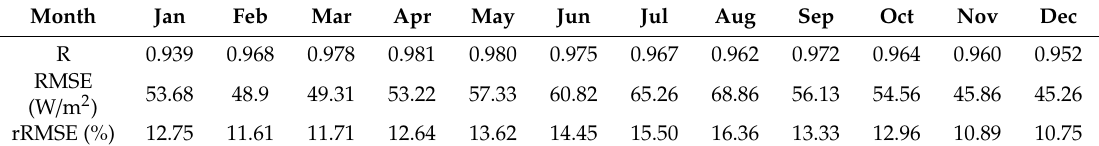
Figure 7. Result of the temporal validation of the ANN model for ( a ) the train dataset (2016), ( b ) the test dataset (2017).